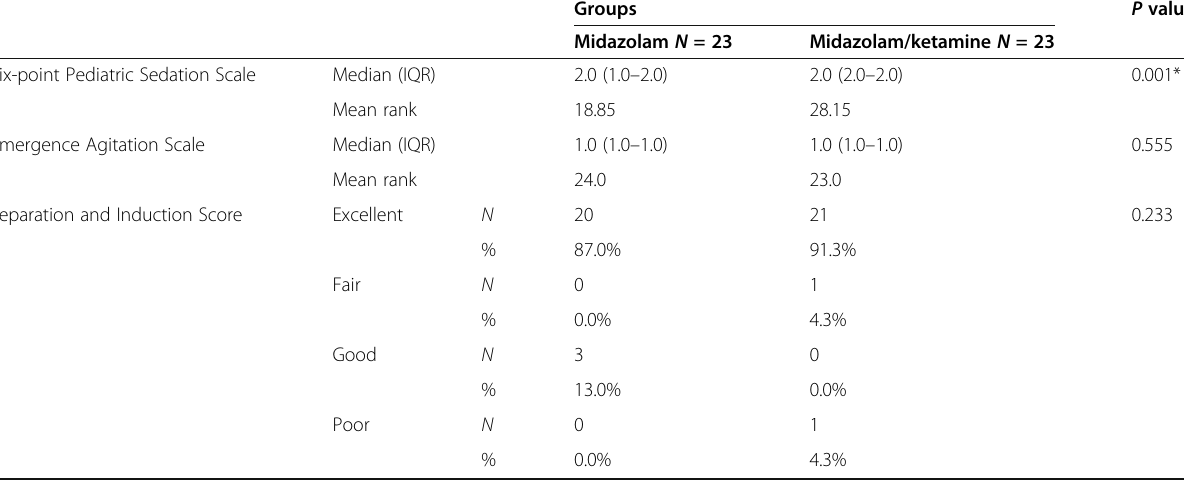
Table 2 Comparison of the primary outcomes between the studied groups